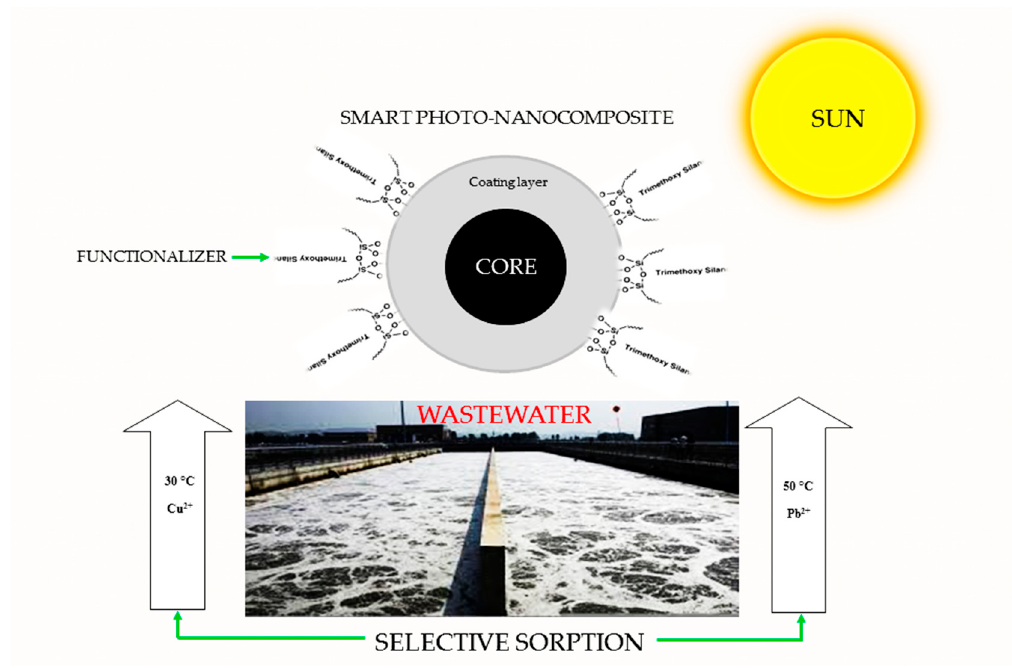
Figure 2. Pictorial representation of a temperature-responsive smart nanocomposite, showing selective adsorptions of Cu 2+ and Pb 2+ at 30 °C and 50 °C, respectively.